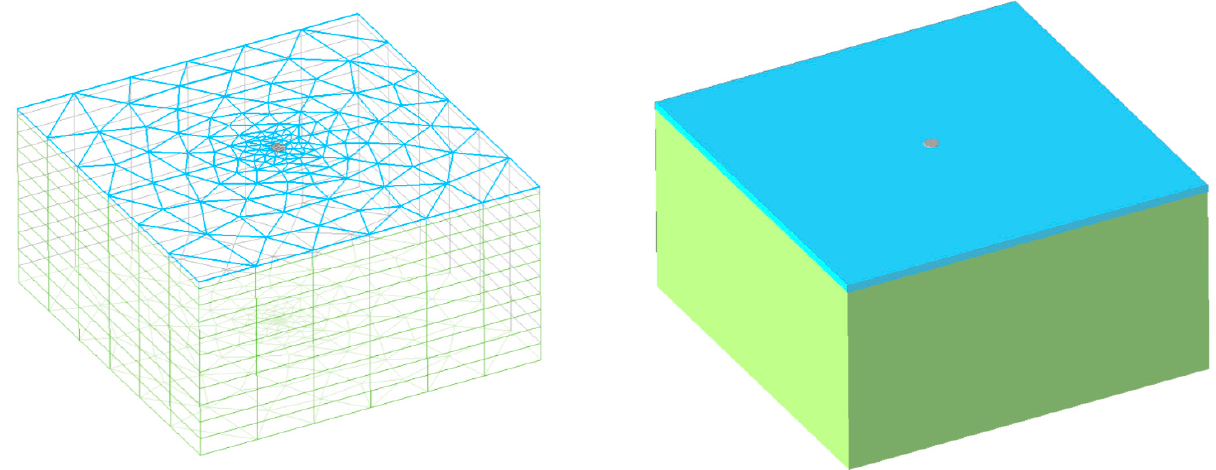
Figure 10. FEM model of the load test with mesh and render.